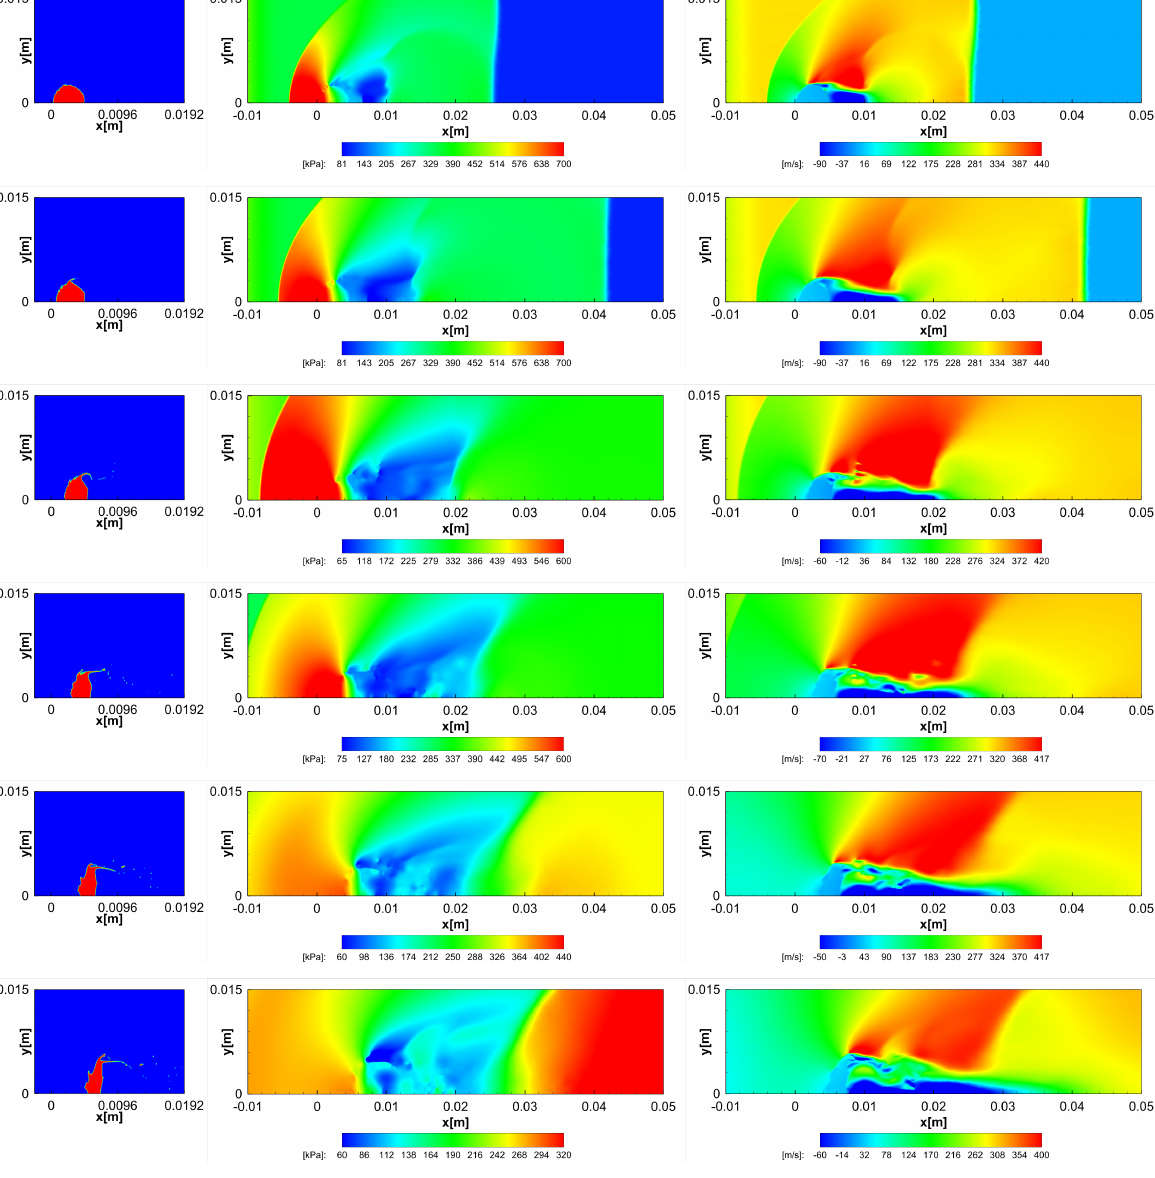
Figure 5. Instantaneous contours for volume fraction of water, pressure, and streamwise velocity fields (from left to right), corresponding to t ∗ = 0.17, 0.27, 0.45, 0.55, 0.7 and 0.85 (from top to bottom).